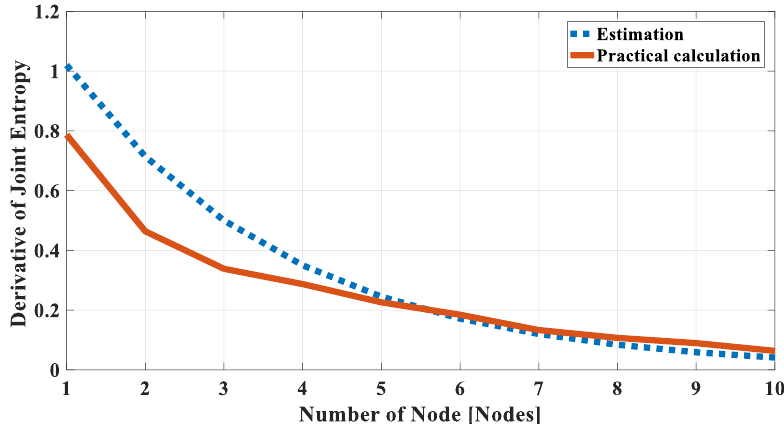
Figure 6. The derivative of estimated joint entropy and calculated joint entropy of the dataset 1.